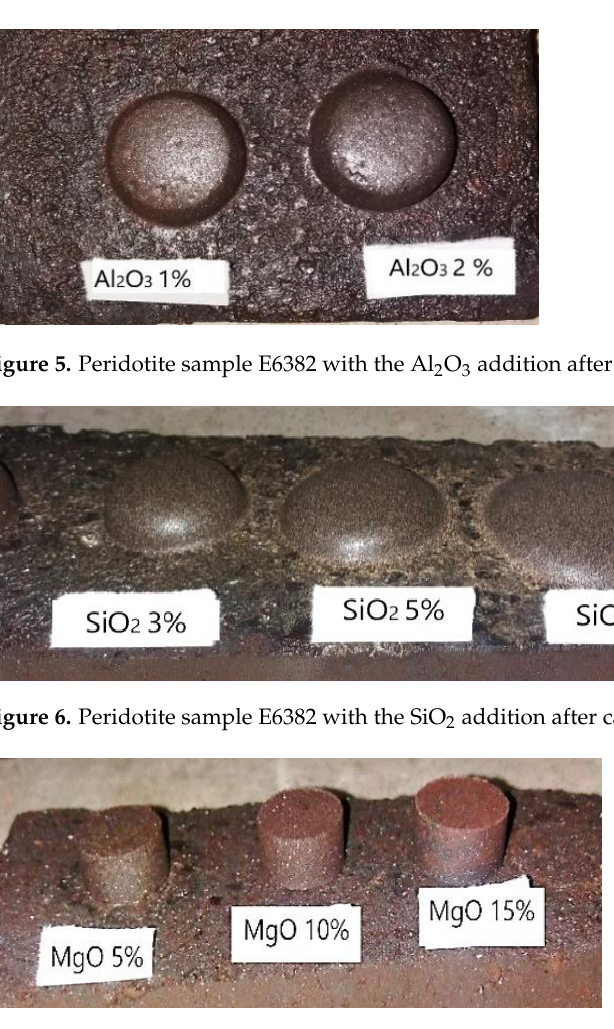
Figure 4. Peridotite sample E6382 with the CaO addition after calcination.